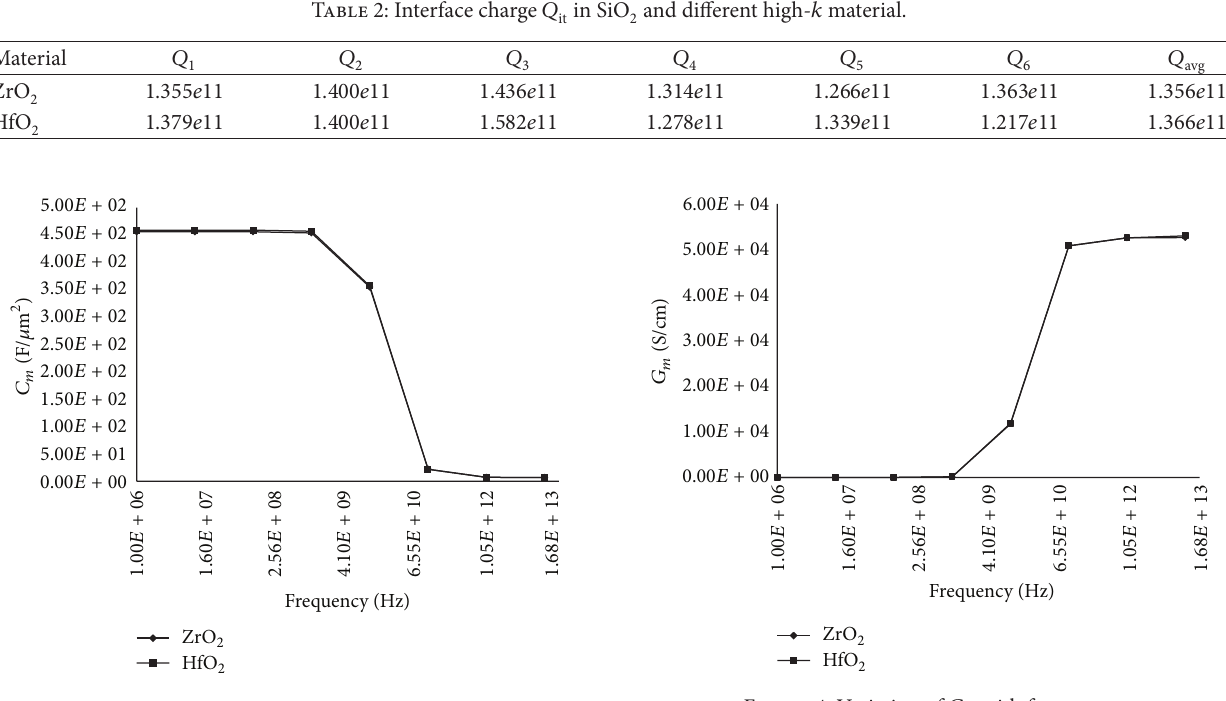
Figure 3: Variation of 𝐶 𝑚 with frequency. Figure 4: Variation of 𝐺 𝑚 with frequency.